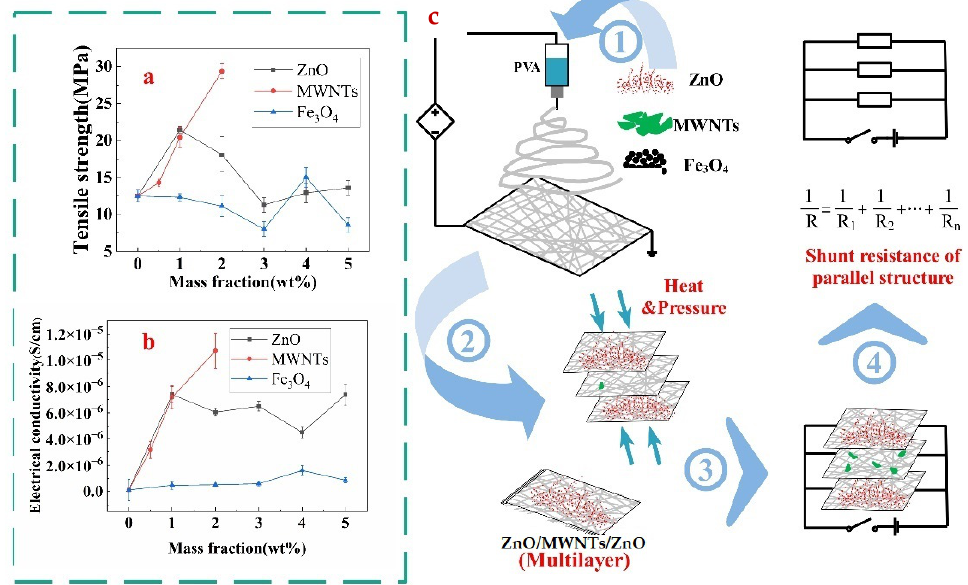
Figure 4. The comparison of different properties of monolayer membranes: ( a ) Tensile strength; ( b ) electrical conductivity at 10 7 HZ frequency and ( c ) the production of multilayer nanofibre mem- branes used by optimal single-layer membranes.